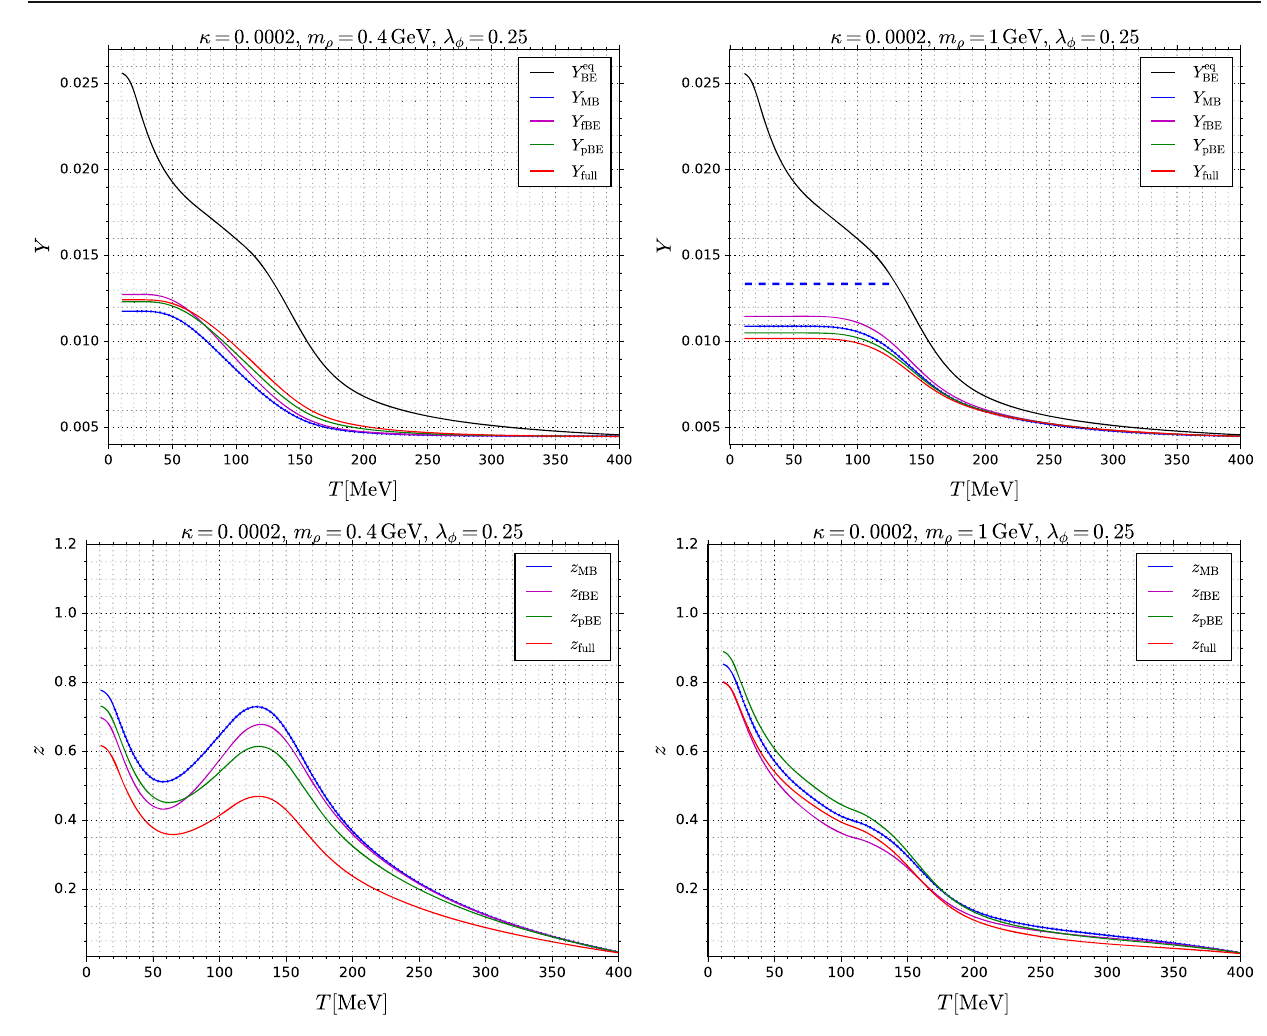
Fig. 2 Yield Y (upper panels) and pseudopotential z (lower panels) of Goldstone boson σ as functions of temperature for λ φ = 0 . 25, κ = 2 · 10 − 4 and for two values of m ρ – see black dots in the upper